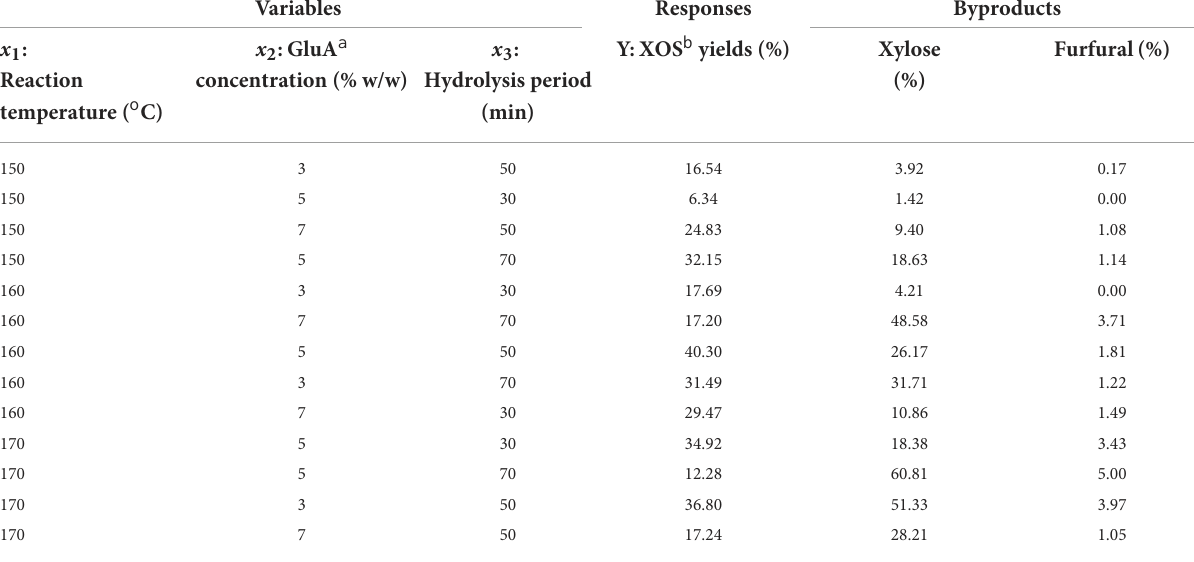
TABLE 1 Different combination of independent variables of software design and experimental results. Variables Responses